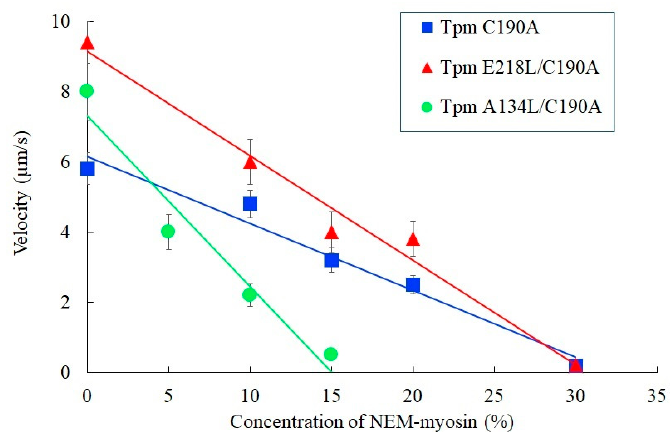
Figure 6. The dependence of the sliding velocity of thin filaments containing A134L / C190A, E218L / C190A, and C190A Tpm on the NEM-modified myosin concentration in the in vitro motility assay at p Ca 4. The fraction of NEM-myosin required to stop the filament movement is a measure of relative force, which myosin can develop. Each data point represents the mean ± SD of three experiments. To stop the movement of thin filaments with C190A Tpm, A134L/C190A Tpm, and